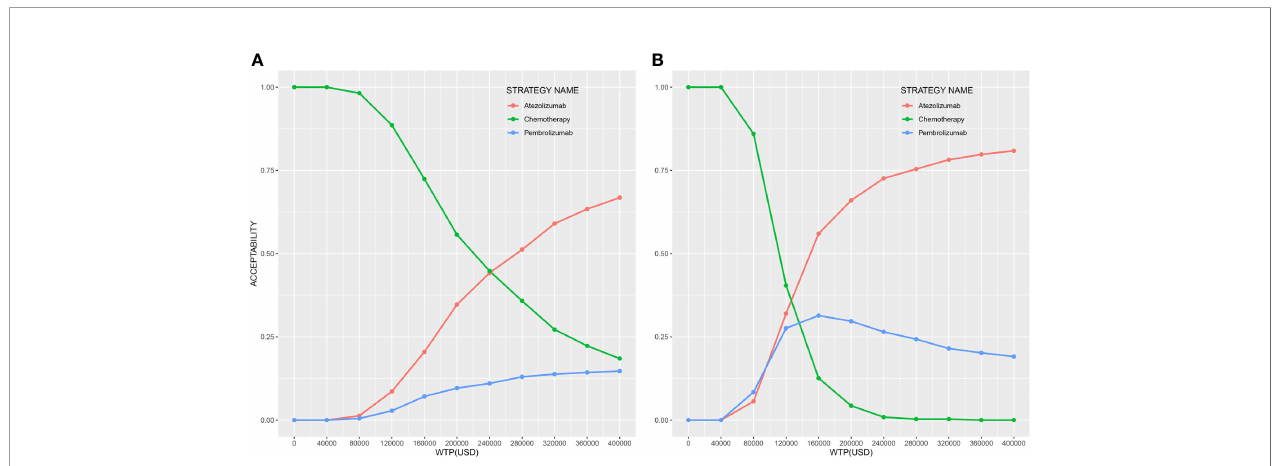
FIGURE 3 | Cost-effectiveness acceptability curves of three strategies (A) in any PD-L1 expression population and (B) in high PD-L1 expression